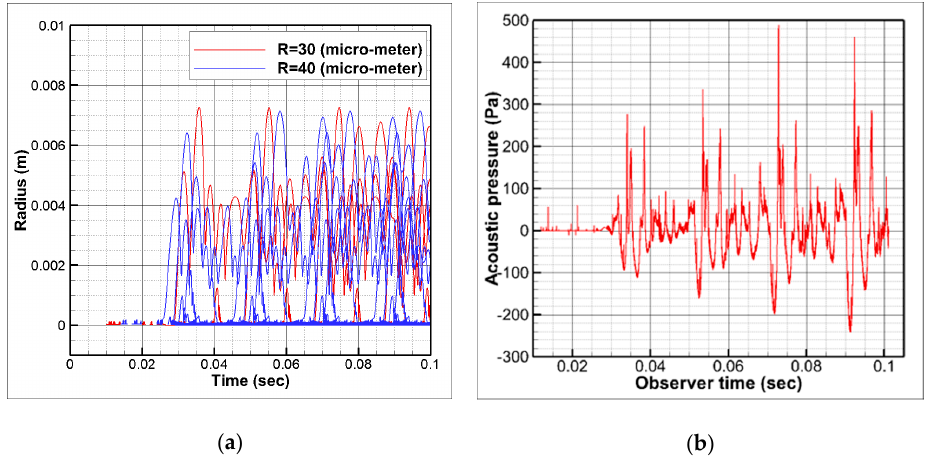
Figure 21. Comparison of wing-tip vortex cavitation between the experiment and bubble dynamics simulation; ( a ) experiment; ( b – i ) numerical results.